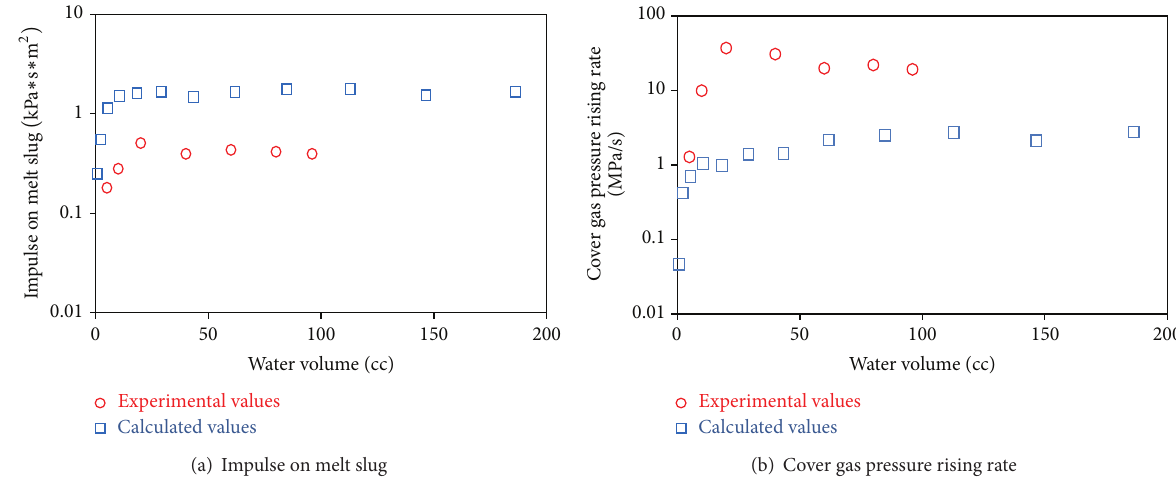
Figure 10: Experimental and calculated pressure characteristics at varying water quantities. Table 4: Time period of premixing phase.